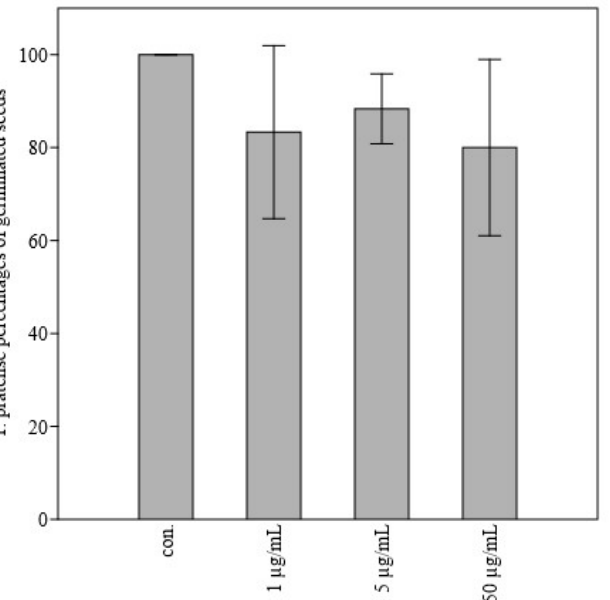
Figure 3. Bar-chart showing Trifolium pratense percentages of germinated seeds after application of 1 µg/mL, 5 µg/mL, and 50 µg/mL of Juniperus horizontalis essential oil in comparison to control.